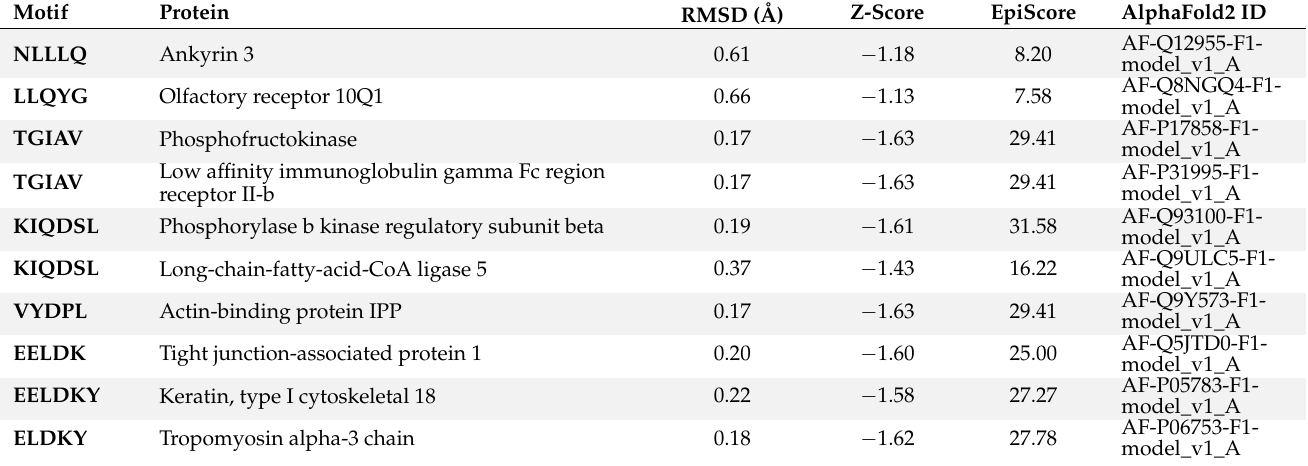
Table 2. Human AF-3D-mimics for SARS-CoV-2